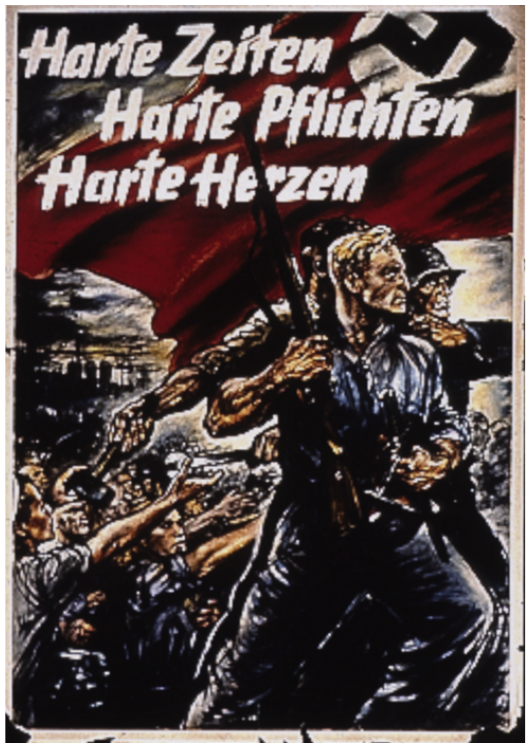
Fritz R. Weber, "Hard times, hard duties, hard hearts," 1943.